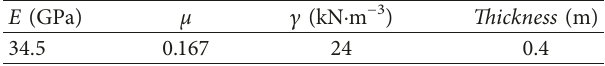
Table 3: Lining calculation parameters.